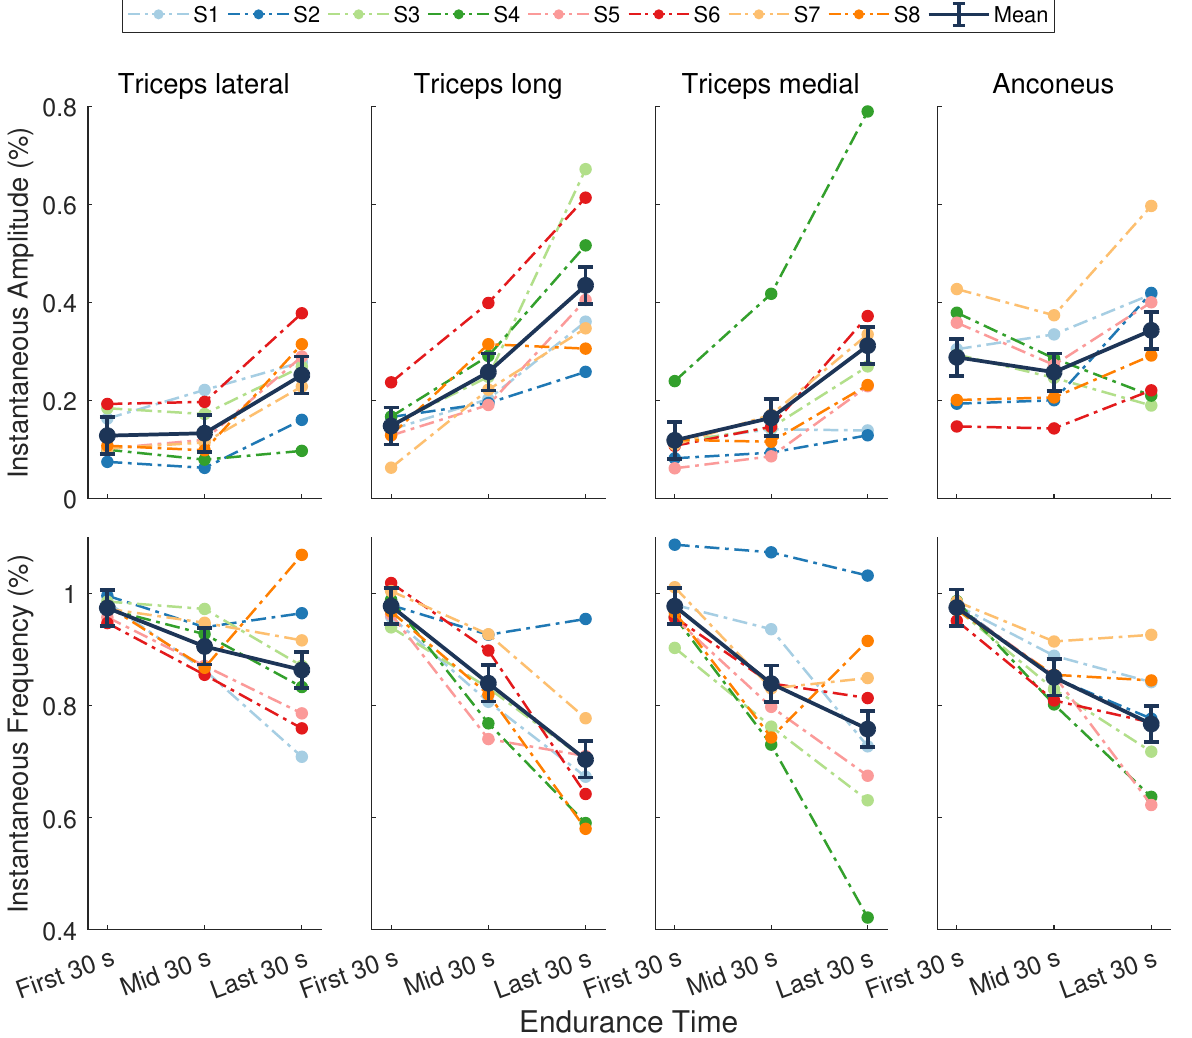
Figure 5. Normalized sEMG features from the elbow extensor muscles. ( Top ) Instantaneous amplitude ( a i ( t ) ) and ( Bottom ) instantaneous mean frequency ( f im ( t ) ). Dark points separated by solid lines are means ± SE for the first, middle, and last 30 s of the task. Dotted lines represent data from a single participant ( n = 8) whose assigned color is consistent across figures. There was a significant main effect of time for f im ( t ) ( p < 0.001, η 2 p = 0.83) and a i ( t ) ( p < 0.001, η 2 p =